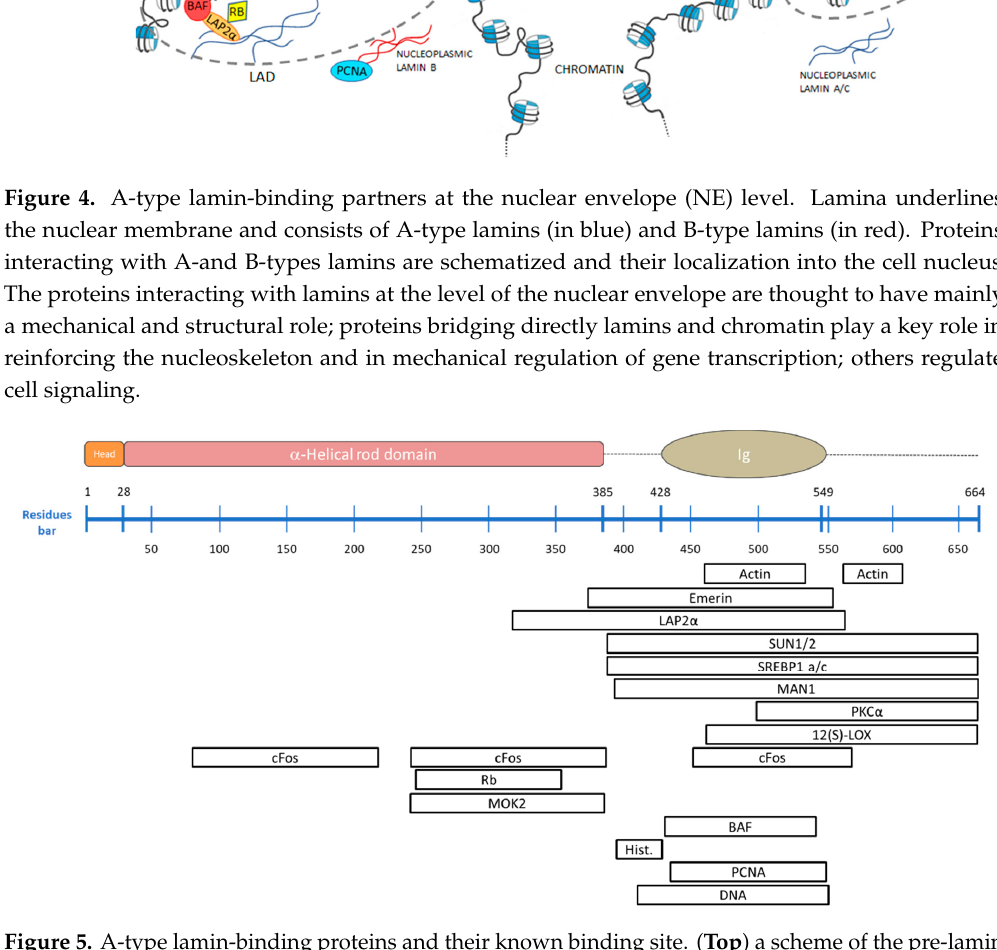
Figure 5. A-type lamin-binding proteins and their known binding site. ( Top ) a scheme of the pre-lamin A structural domains, schematized in the N-terminal head, the central coiled-coil region (including the coil 1A, coil 1B and coil 2 shown in the previous figures), and the C-terminal tail including the Ig-fold domain. The residues bar indicates the positions of the respective amino acids. The amino acids after residue 646 are normally removed by proteolytic cleavage to generate mature lamin A. Lamin C is identical to lamin A till residue 566 and contains 6 lamin C-specific amino acids at its C-terminus. ( Bottom ) List of A-types lamin binding proteins and their relating binding